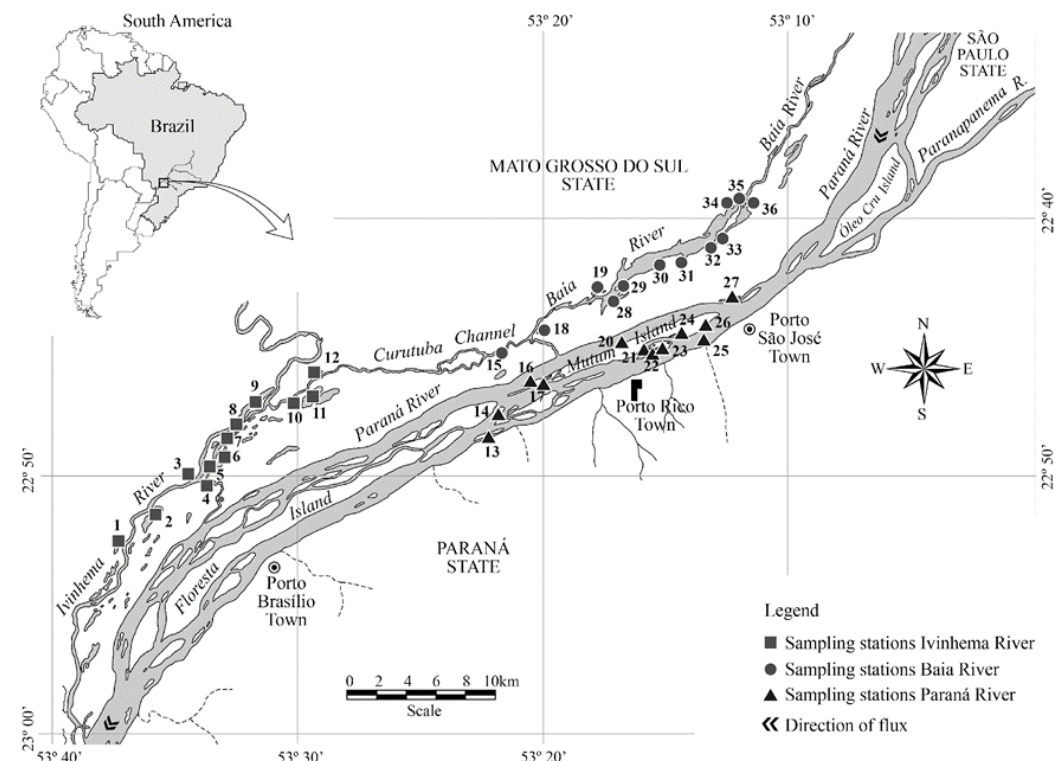
Figure 1. The upper Paraná River floodplain. From Jaime Luiz Lopes